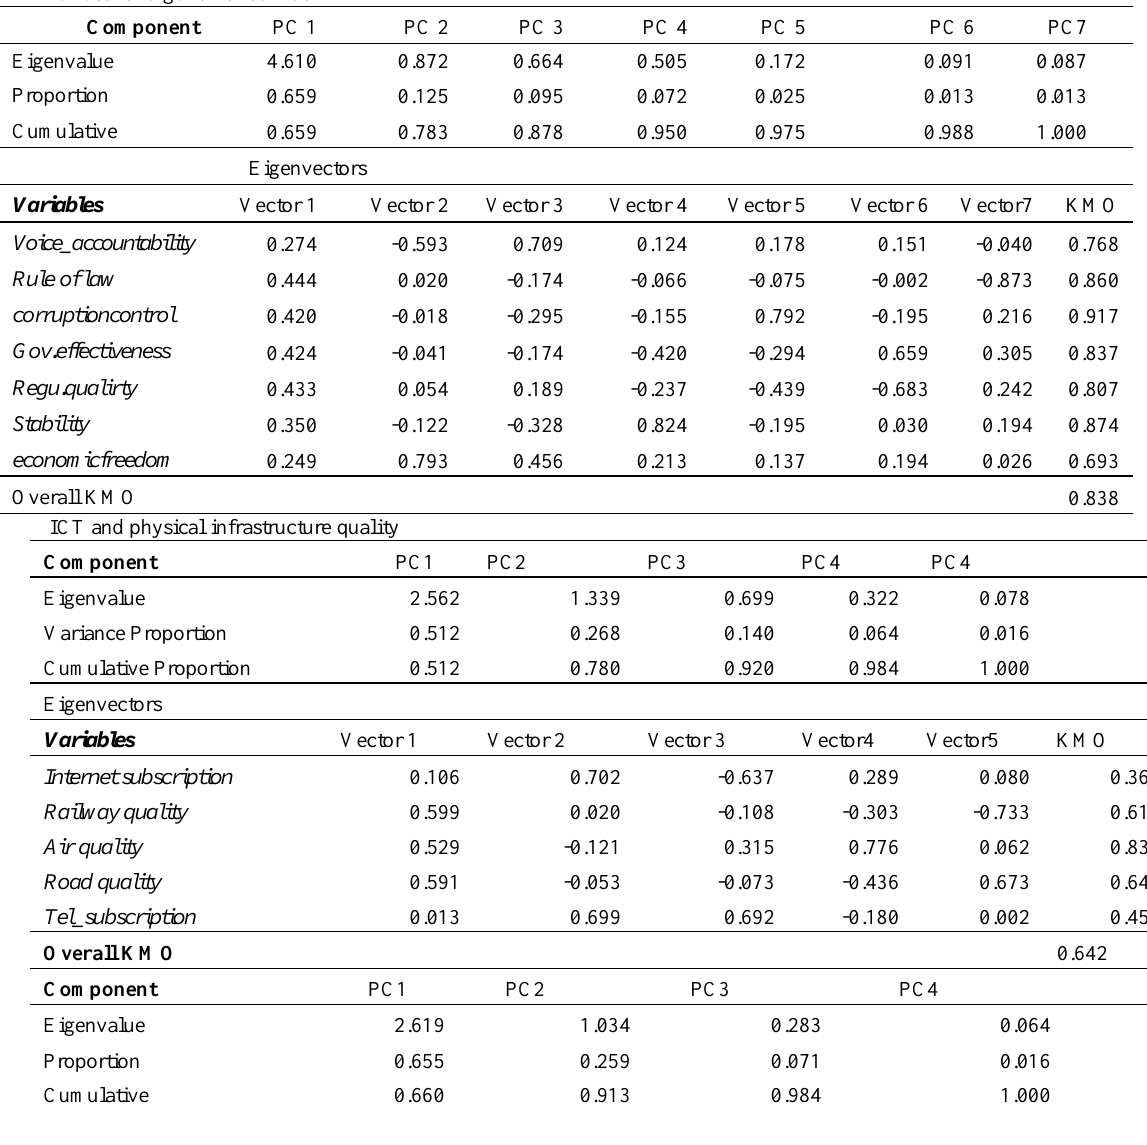
Table 7 : Results of the principal component